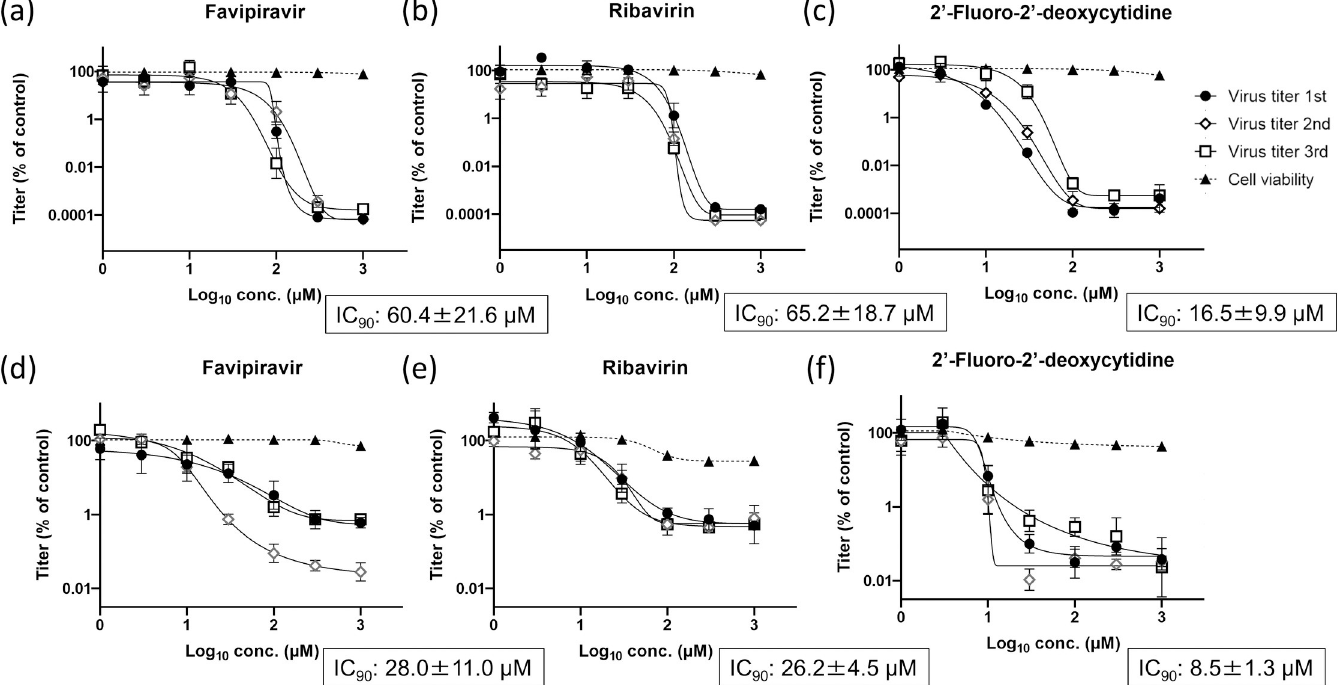
Fig 1. Inhibitory effects of FPV, RBV, and 2’-FdC on the replication of JCV in Vero and N2A cells. The inhibitory effect of FPV (a), RBV (b), and 2’-FdC (c) on the replication of JCV in Vero cells and the respective cytotoxic effect were assessed. The same parameters were measured in the context of N2A cells (d-f). Vero cells and N2A cells were infected with JCV at a multiplicity of infection of 0.001 and 0.1 in the presence of various concentrations of FPV, RBV, and 2’-FdC, cultured at 37˚C for 2 days and 3 days, respectively. Cell viability was evaluated in non-infected cells treated under the same conditions of drugs. Three wells were used in a single independent experiment and then three independent experiments were performed. The relative titers were calculated and are shown as mean values with standard deviations.